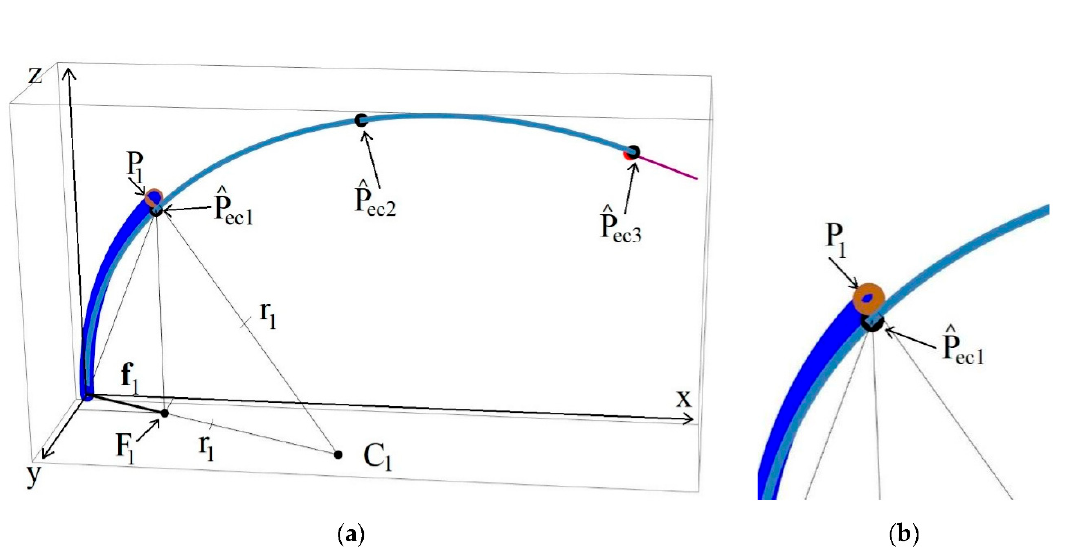
Figure 8. Robot first segment, when a segment’s form is an arc, endpoint P 1 representation: ( a ) the point P 1 with approximate spine curve view; ( b ) points P 1 and ˆ P ec1 , zoomed